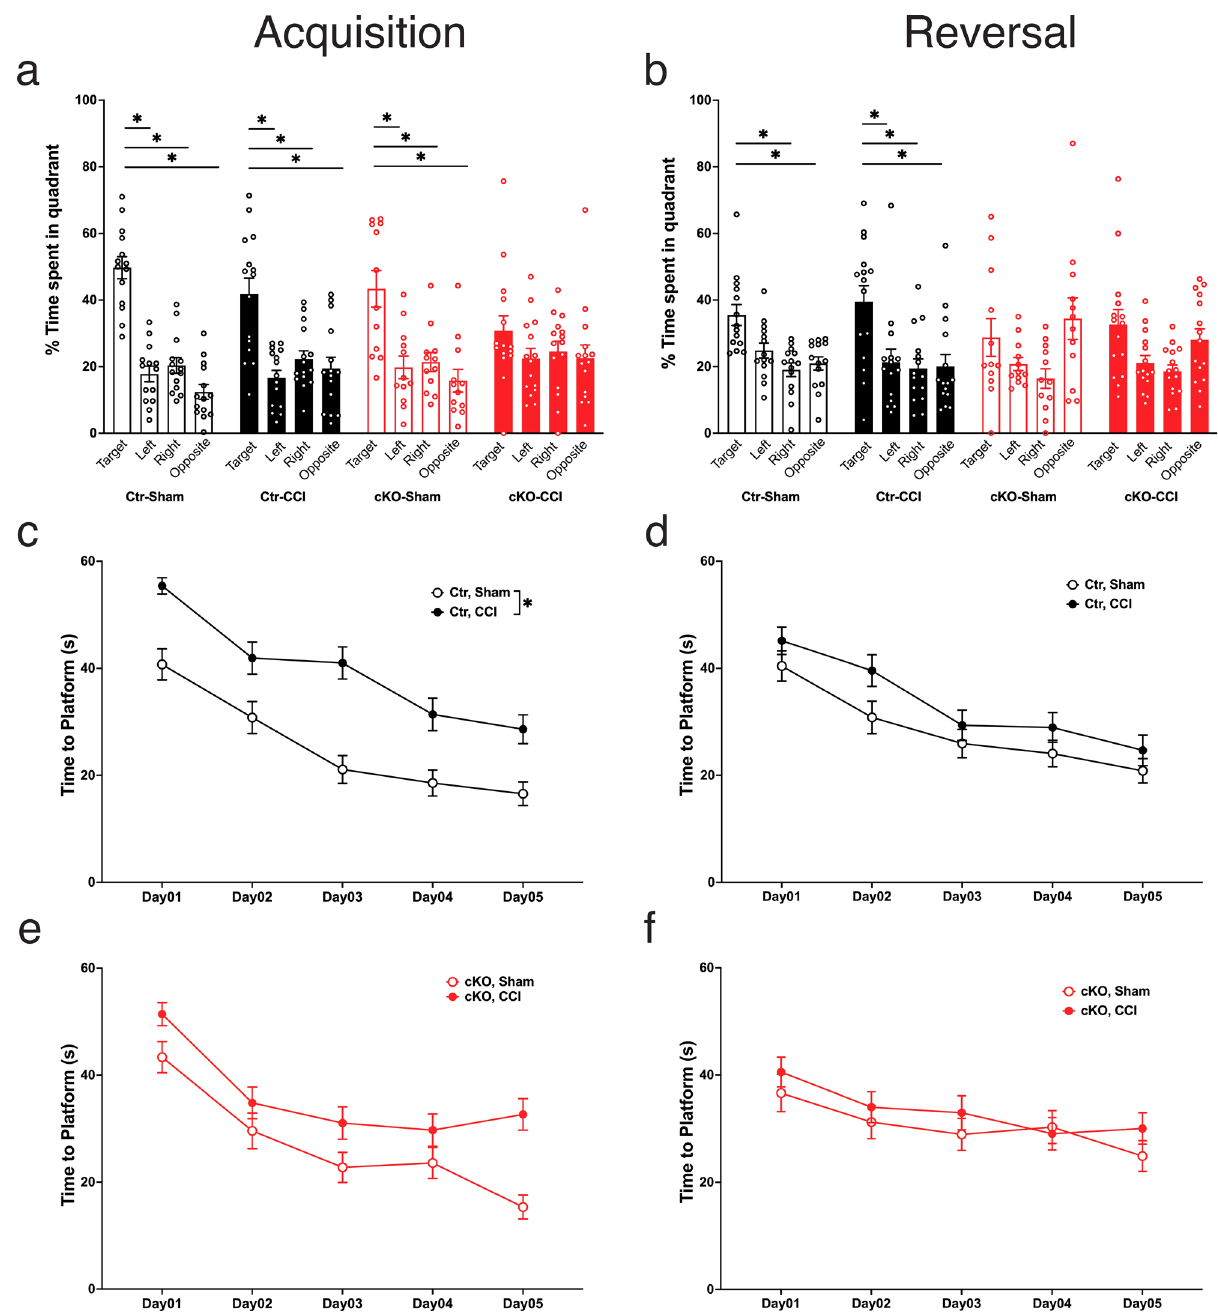
Fig. 6 Impaired spatial learning in astrocytic ApoE-de fi cient mice was worsened by CCI in the Morris water maze test. a Astrocytic ApoE de fi ciency did not affect spatial memory in uninjured mice after acquisition training but did impair memory in cKO mice with CCI. b Astrocytic ApoE de fi ciency alone was suf fi cient to impair reversal memory. The same impairment was seen in cKO mice with or without CCI. c , e During the acquisition training session, injured mice exhibited longer latency to the platform than sham-operated mice. This was signi fi cant in controls and approaching signi fi cance in cKO mice. d , f During the reversal training session, no difference was observed. Data are presented as means ± SEM. *P <